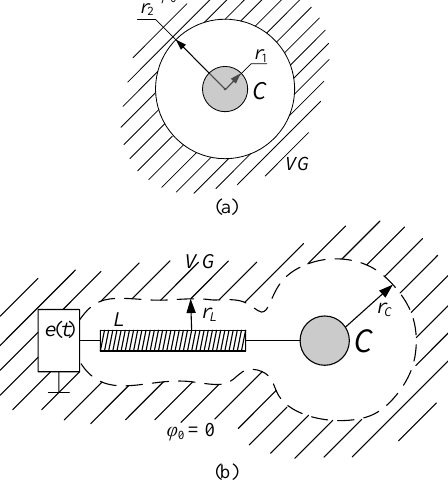
Fig. 5. Electrical scheme of Tesla coil model.